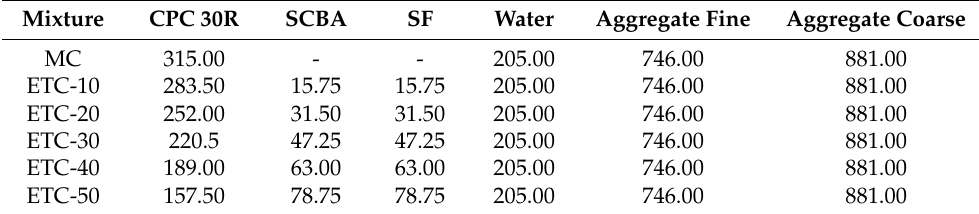
Table 3. Dosage of ternary concrete mixtures (Kg/m 3